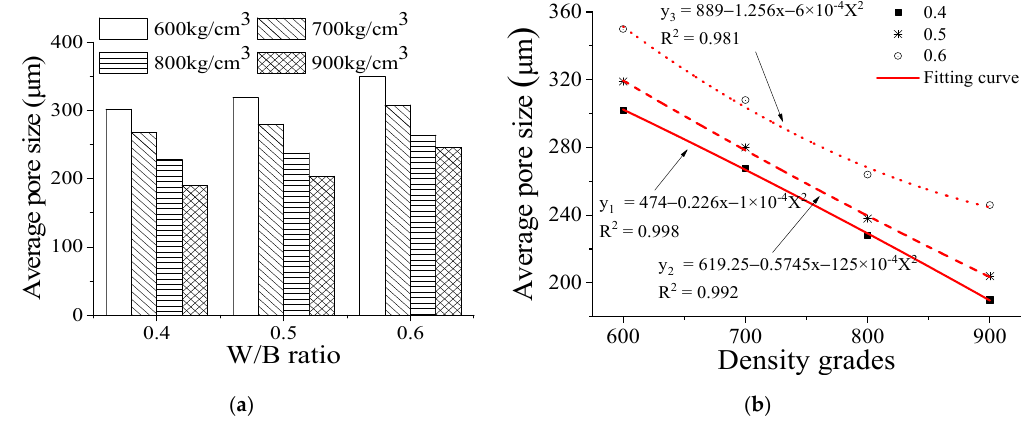
Figure 2. Effect of water–binder ratio on average pore size of the foam backfill material at different density grades. ( a ) W/B ratio; ( b ) Density grades.